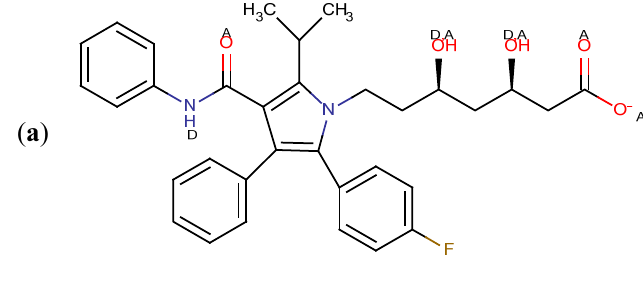
Figure 1. Proton acceptor (A) and proton donor groups (D) of atorvastatin ( a ), ortho - hydroxylated metabolite ( b ), para -hydroxylated metabolite ( c ) and atorvastatin lactone ( d